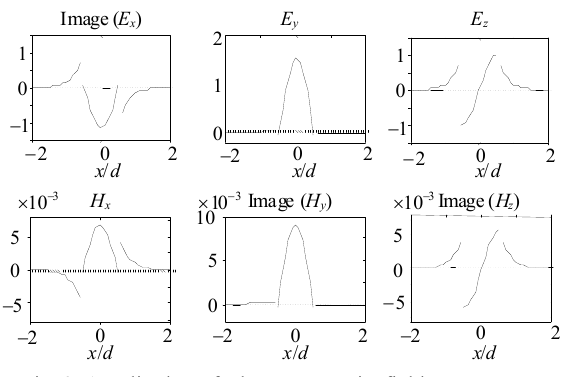
Fig. 3 Amplitudes of electromagnetic field components at 2.2 k d  for RCP odd mode when m = 1, 0